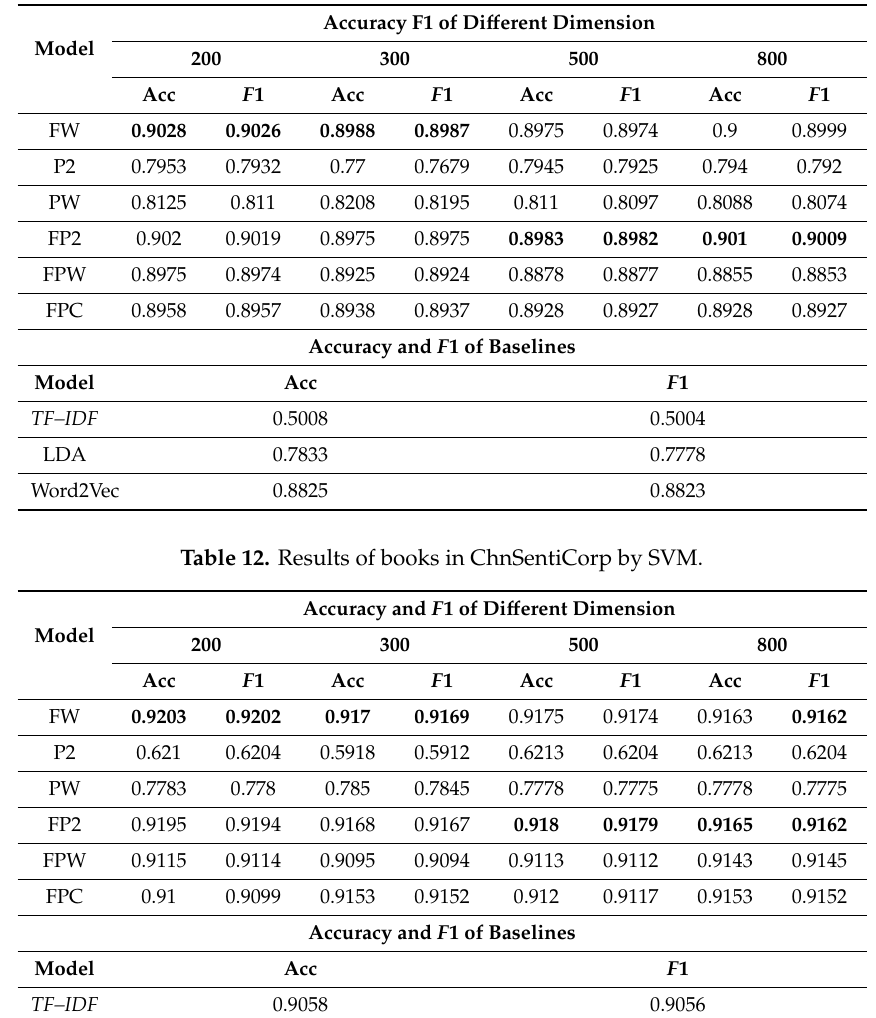
Table 11. Results of books in ChnSentiCorp by KNN.